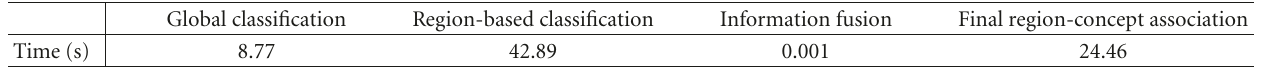
Table 5: Processing time for 800 × 600 pixels